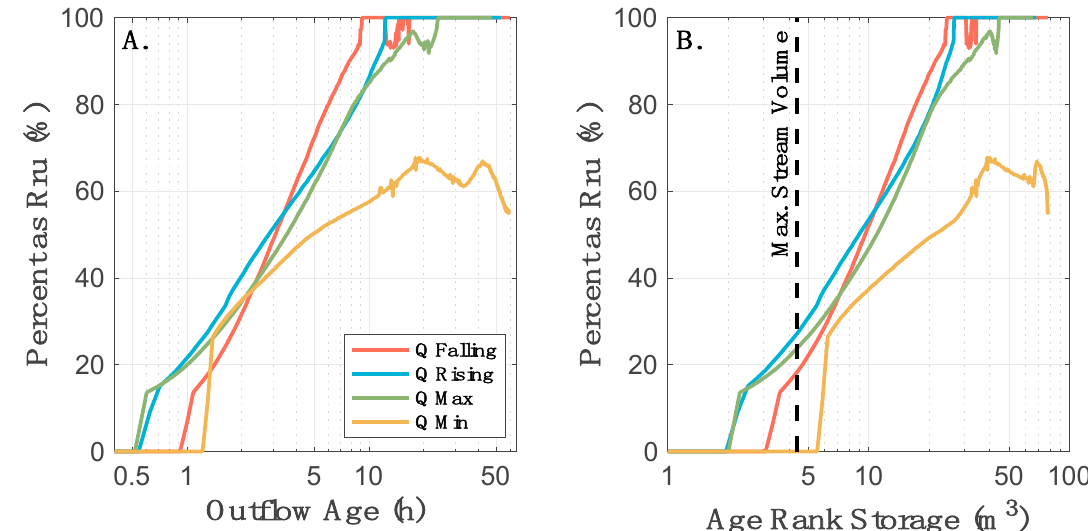
Figure 6. Fraction of outflowing Raz that has been transformed to Rru as a function of ( A ) outflow age, and ( B ) age-ranked storage in the study reach.